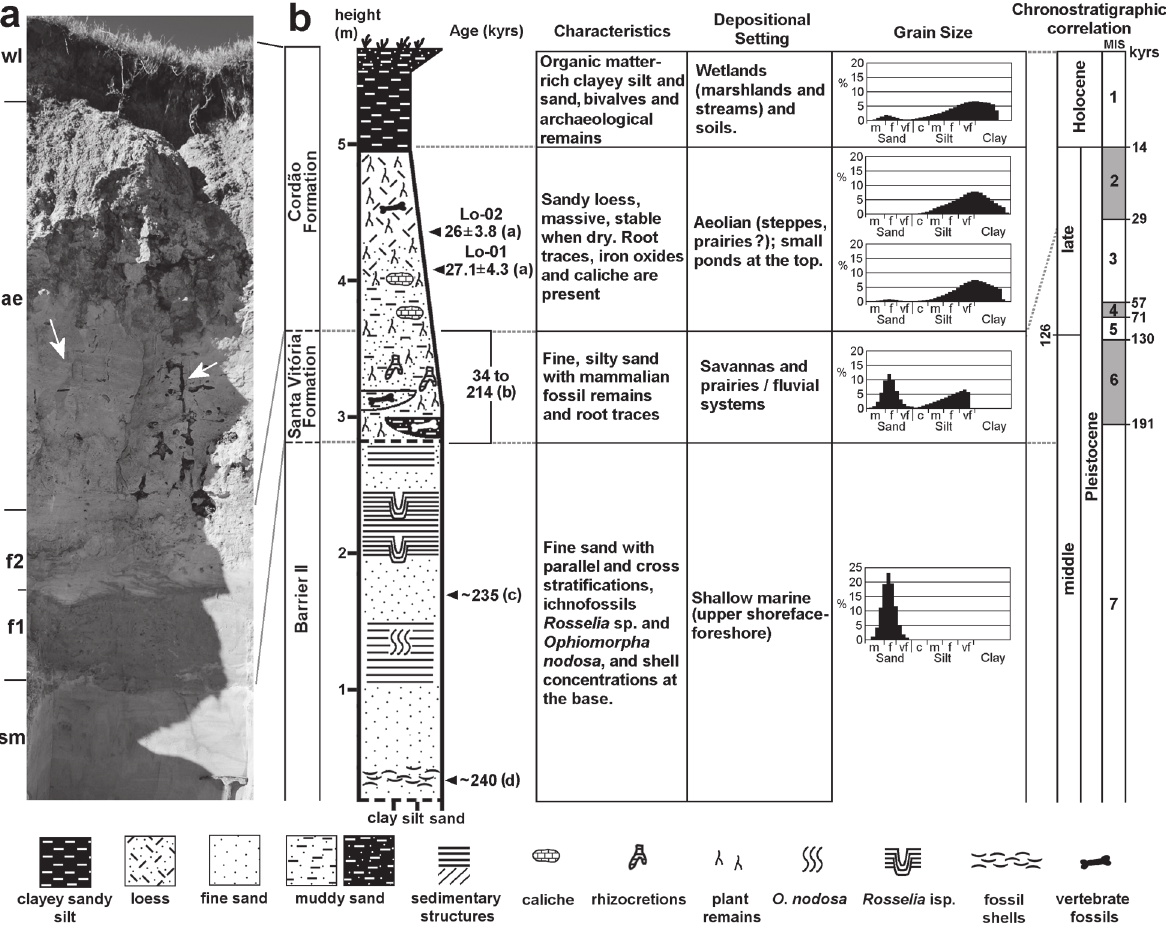
Figure 2 - a: Stratotype section of the Cordão Formation showing the succession of depositional environments (sm = shallow marine, f1 and f2 = fluvial, ae = aeolian, wl = wetlands), the right arrow indicates subhorizontal laminations, and the left one show root traces. b: Stratigraphy, description of the main characteristics and interpretation of the facies succession exposed on the banks of Chuy Creek. The chronostratigraphic correlation is based on: (a) OSL ages (this paper), (b, d) ESR ages from Lopes et al. (2010, 2013) and (c) TL ages from Lopes et al.